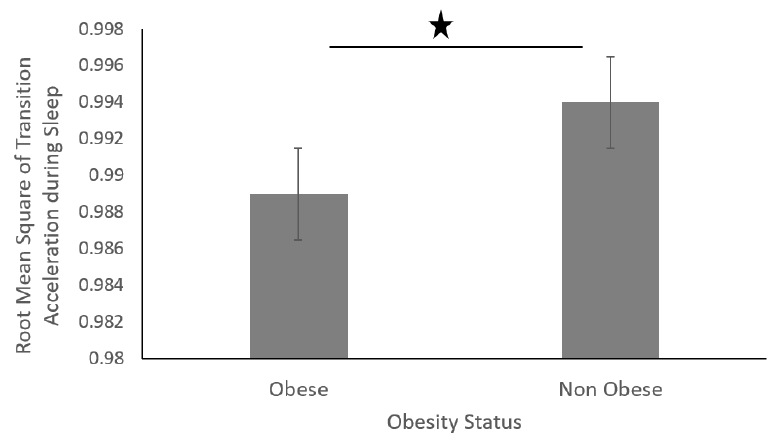
Figure 17. Number of transitions in each phase of sleep.